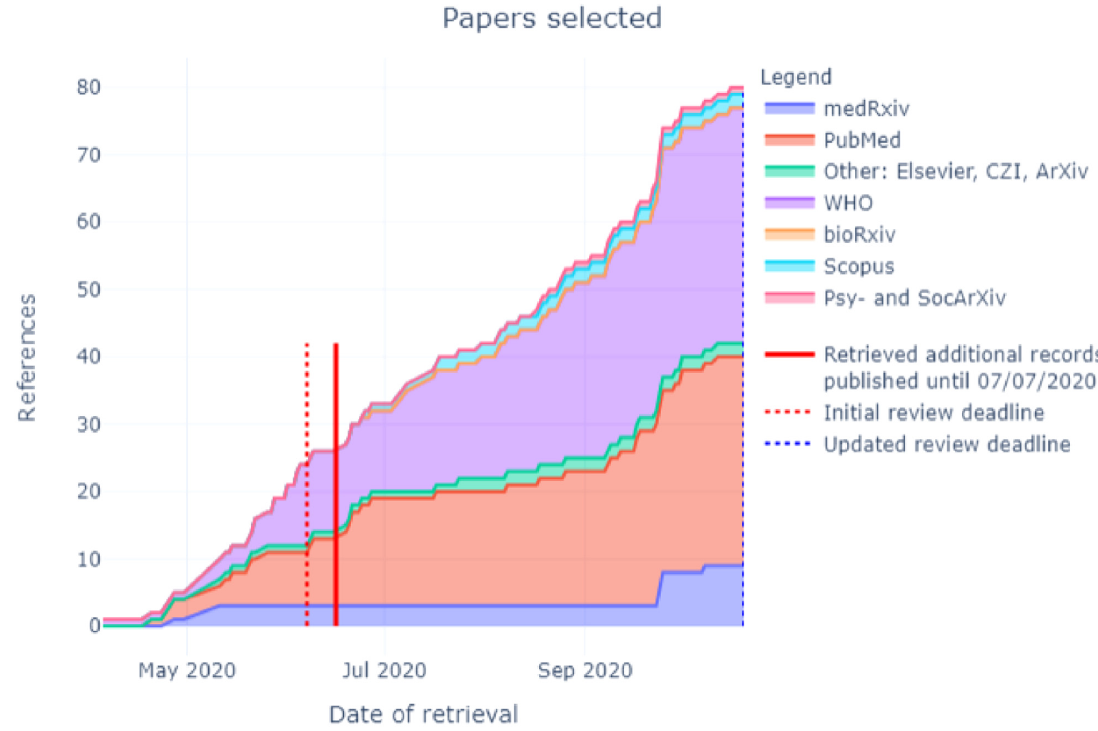
Figure 4. Number of articles selected by database and repository over